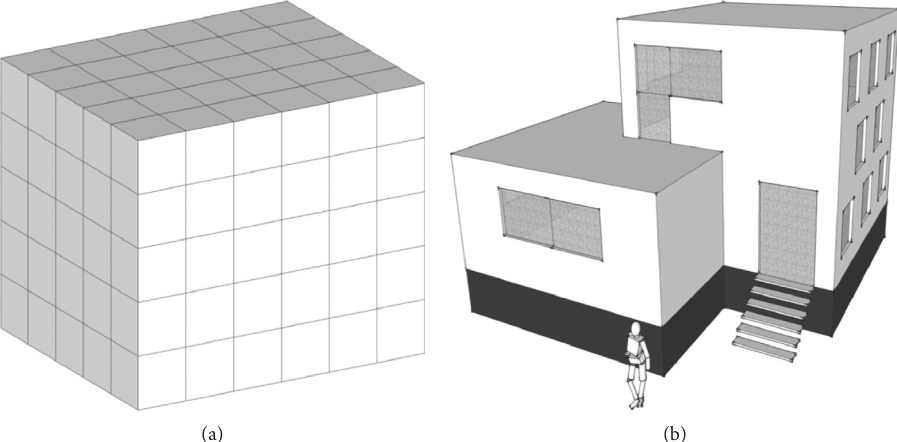
Figure 1: Model of building generated by orthohedrons (orthogonal parallelepipeds). (a) Orthohedron with spatial grid modulated to 6M. (b) Building